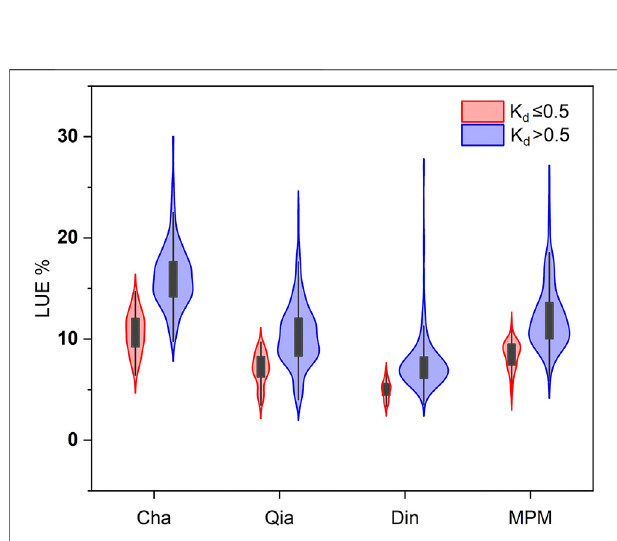
FIGURE 8 | LUE under different radiation conditions at FLUXNET forest